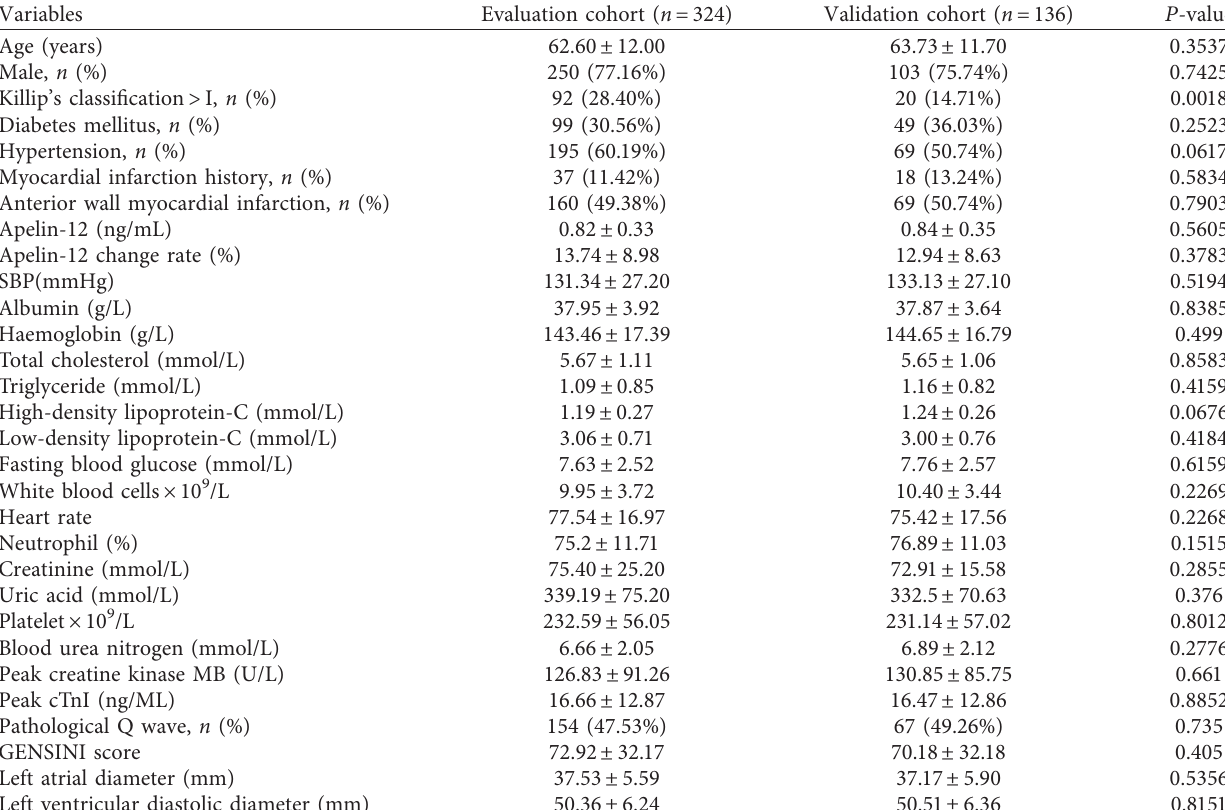
Table 1: Participant characteristics in evaluation and validation